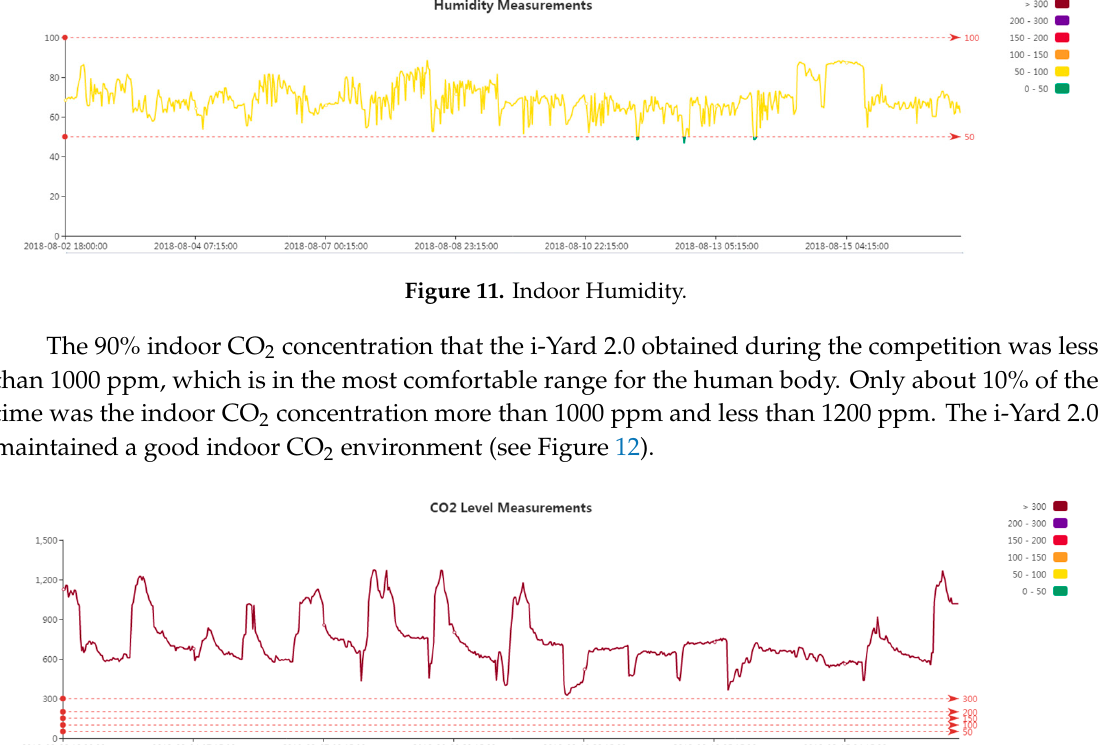
Figure 13. Indoor PM2.5 Concentration. 4. Intelligent Building Control As the “blood” of building, the building system has a decisive influence on the quality of daily use. The building system is not a single system but rather the integration of several subsystems. Through the integration and coordination of each system, the overall stability and security of the system is achieved [49], creating a high-quality building environment. 4.1. Safety Monitoring System Due to the decline in their physiology, the elderly often experience a decrease in mobility and ability to physically recover from injuries. Their bodies also become more vulnerable to other problems like sudden illnesses [50]. Thus, in this design, attention needed to be paid to the inhabitants’ daily life and safety. Therefore, the i-Yard 2.0 team developed an intelligent app system that integrates a series of safety monitoring functions such as maintenance of occupants’ physical condition and means of dealing with emergency situations. Information collected is transmitted to medical supervision, adult children, and outside peers by alarms, SMS messages, etc. The app includes systems for monitoring bodily condition and home positioning, as well as sounding emergency alarms [51]. All three systems acquire and transmit data through bracelets worn by the elderly occupants (see Figure 14).